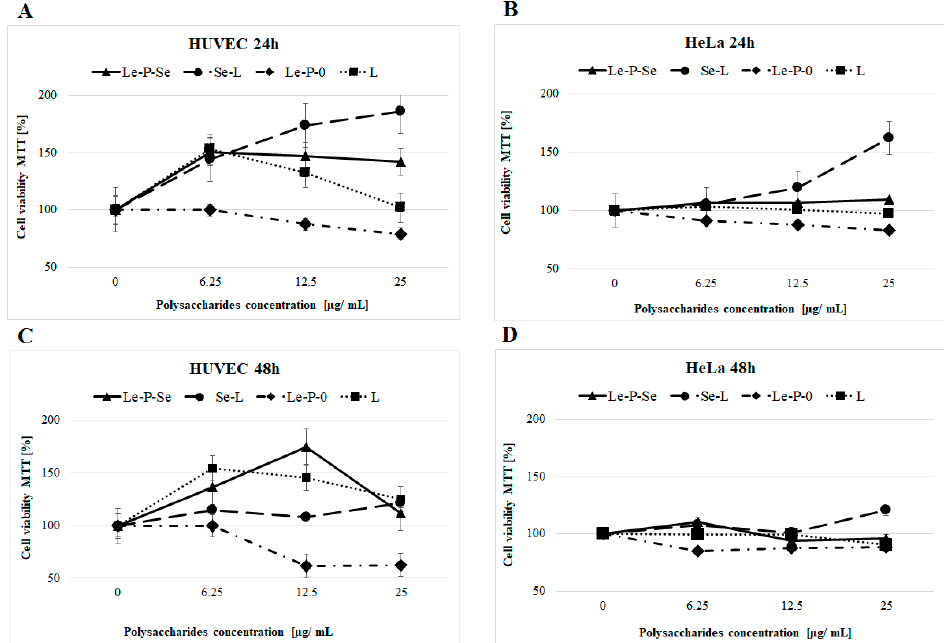
Figure 12. Comparison of the effects of the exopolysaccharide fractions isolated from the culture medium (selenated—Le-P-Se and not selenated Le-P-0) and polysaccharides extracted from the mycelial biomass (selenated—Se-L and not selenated L) [25] on HUVEC and HeLa cells viability. ( A ) HUVEC cells after 24 h of incubation. ( B ) HeLa cells after 24 h of incubation. ( C ) HUVEC cells after 48 h of incubation. ( D ) HeLa cells after 48 h of incubation. The viability of tested cells without added polysaccharide fractions was taken as 100%. The error bars correspond to the standard deviation.